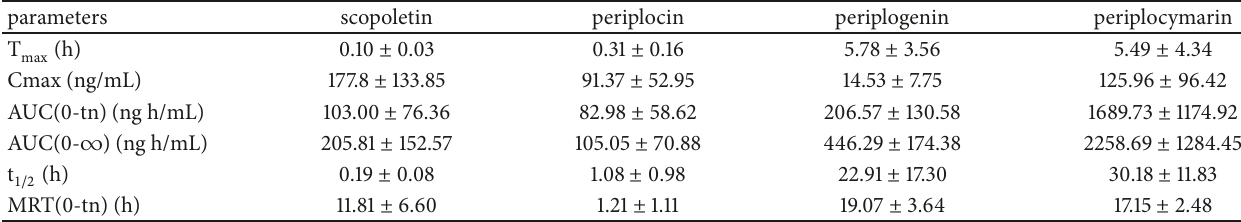
Figure 3: The mean plasma concentration-timeprofiles of four componentsafter oral administration of cortex periplocae extract(n = 6, mean ± SD). Table 3: Pharmacokinetic parameters of the analytes (n = 6, mean ±